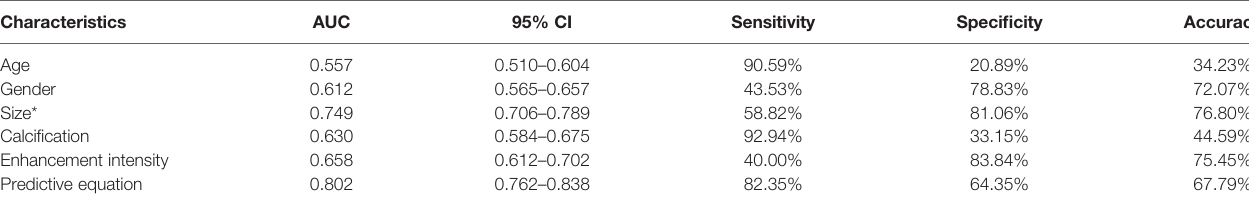
TABLE 2 | ROC analysis for predicting cN1 in